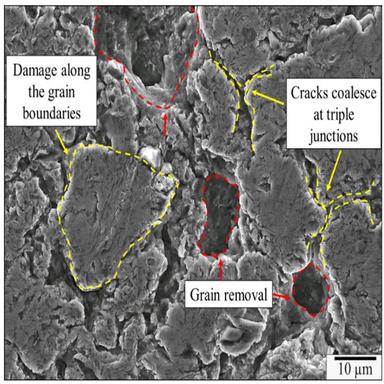
Higher magnification of rosion morphology at the tip of the leading edge (1H5 zone).